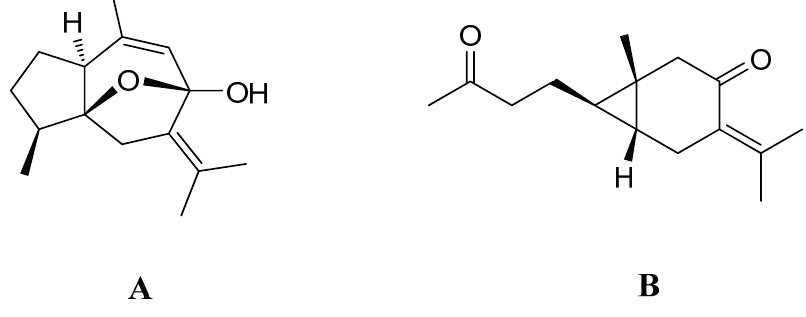
Figure 1. Chemical structures of curcumenol ( A ) and curcumenone ( B